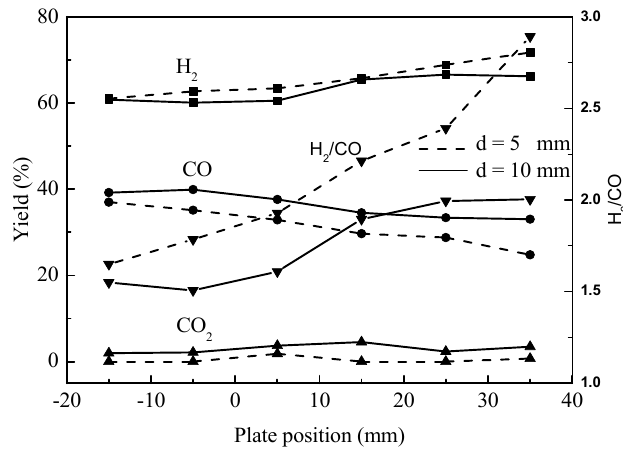
Figure 5. Syngas composition as a function of molten salt addition (temperature: 400 ◦ C, superficial gas velocity: 2.95 mm / s).